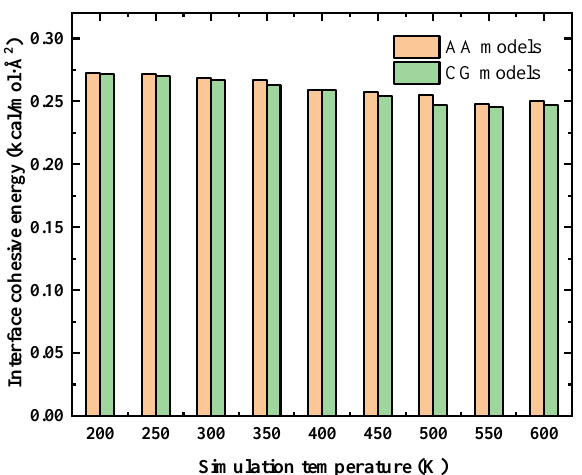
Figure 9. The developed CG models for CNT/epoxy nanocomposites work well over a wide temperature